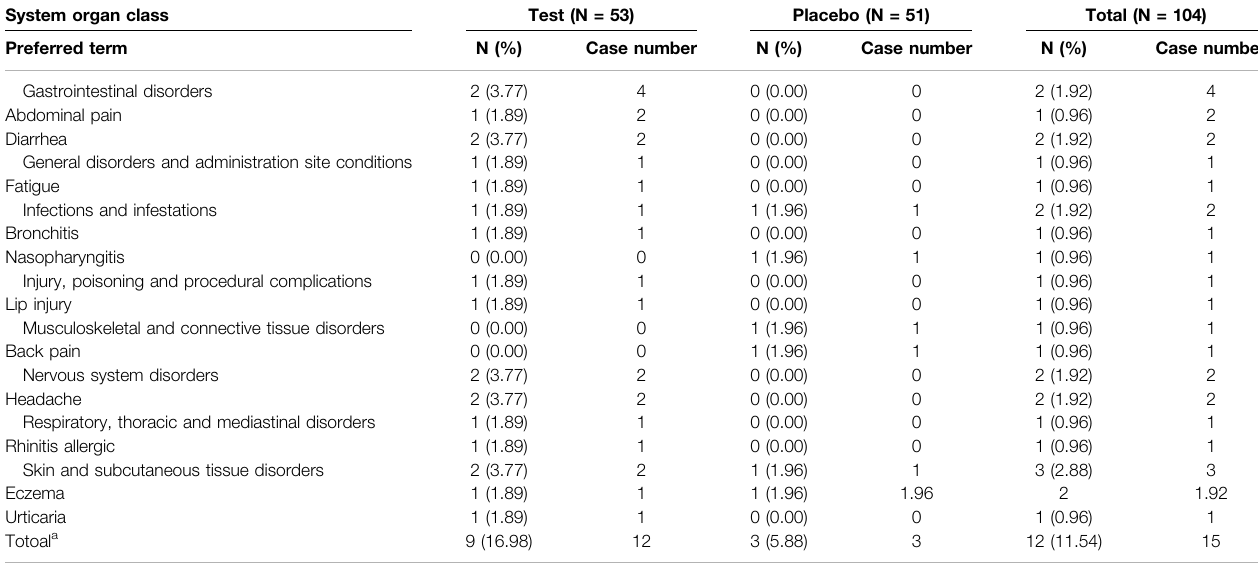
TABLE 7 | Adverse events associated with Golden- Antrodia Camphorata consumption (Safety Set). System organ class